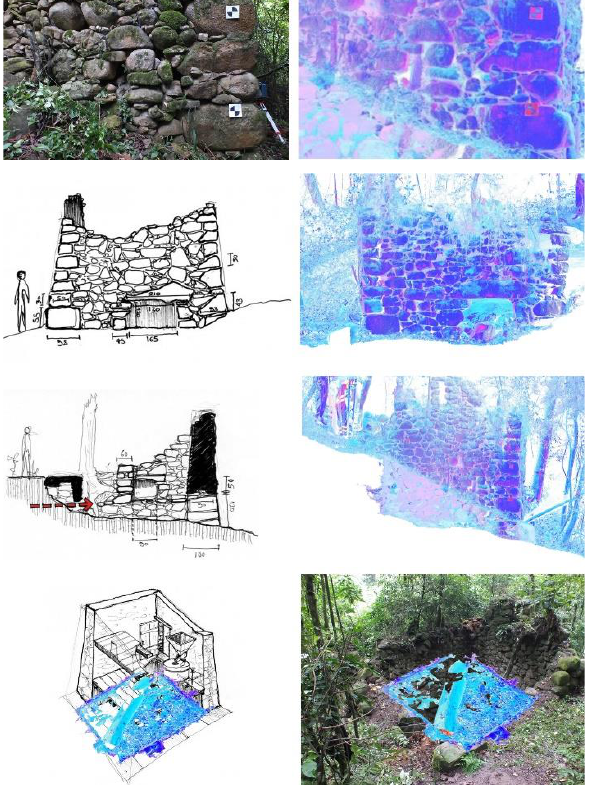
Figure 4: data analyses by point cloud (cyclone software)